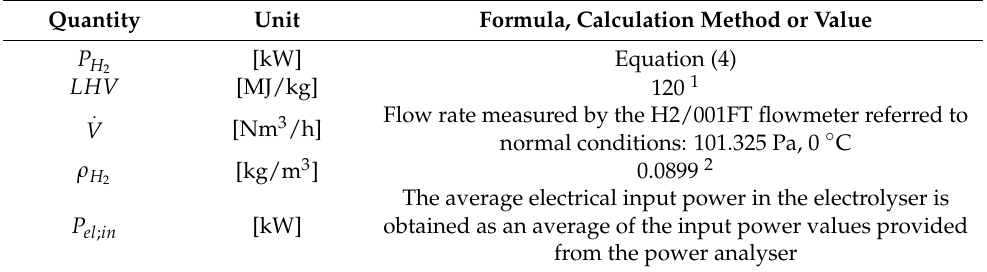
Table 9. Test results for tests with electrolyser operating at 4.6 and 4.2 bar g output pressure. Quantity Unit Electrolyser H 2 outlet flow